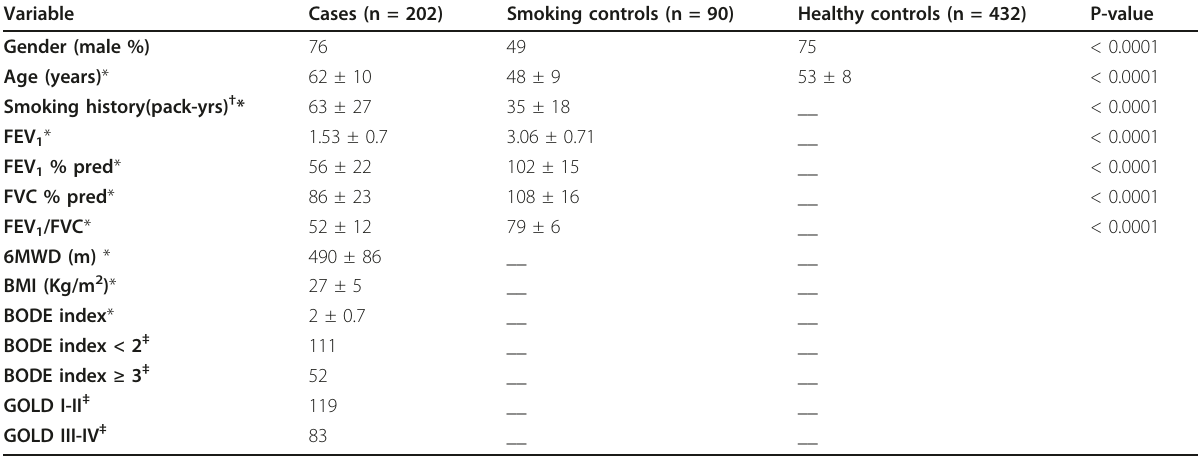
Table 1 Demographic characteristics of COPD patients, smokers and healthy individuals included in the association